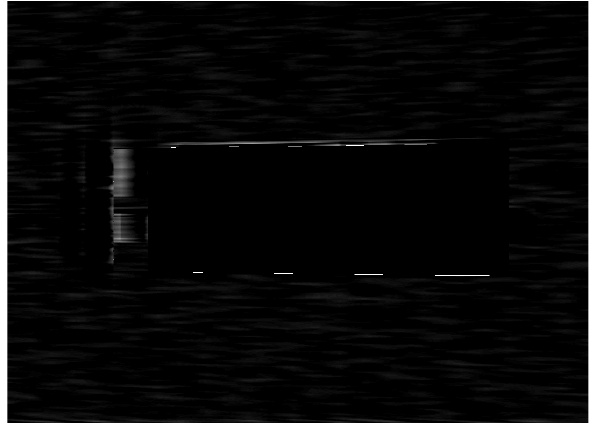
Figure 11. The resulting difference of orthophotos images after the process of iterative minimization. ! An algorithm for fast detection and recognition of foreign objects on a runway was developed. The algorithm automatically detects runway markings and estimates the camera external orientation in the runway coordinate system. The algorithm doesn’t require navigation information of an aircraft for estimation of the external orientation. The only additional information needed is the geodetic coordinates of reference points on the runway. The algorithm detects and estimates the dimension of the foreign object using the difference of the